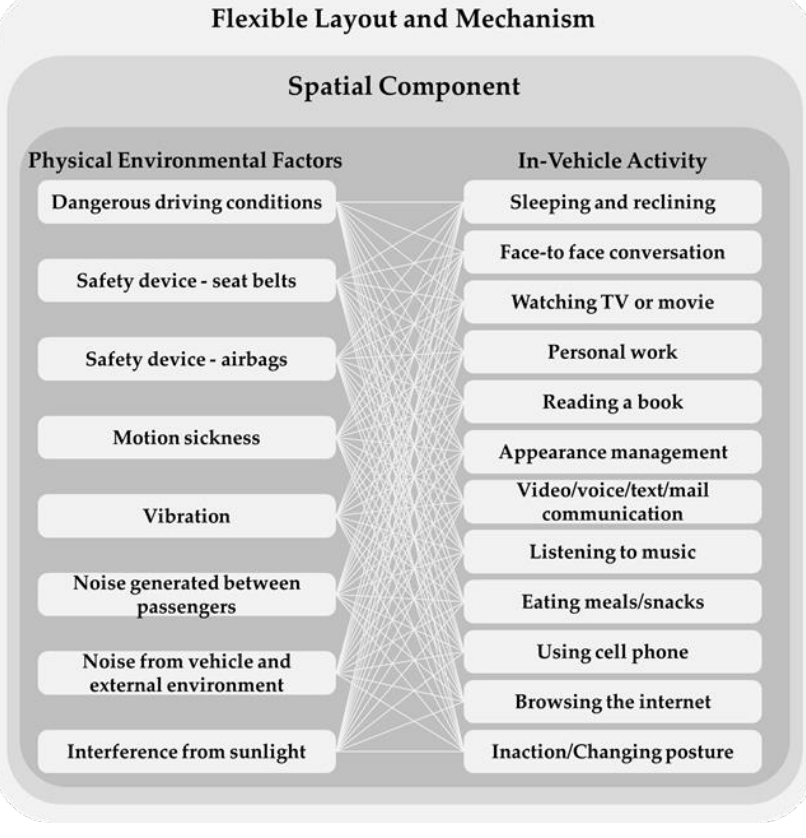
Figure 5. The considerations from the perspective of spatial design to solve problems caused by physical environmental